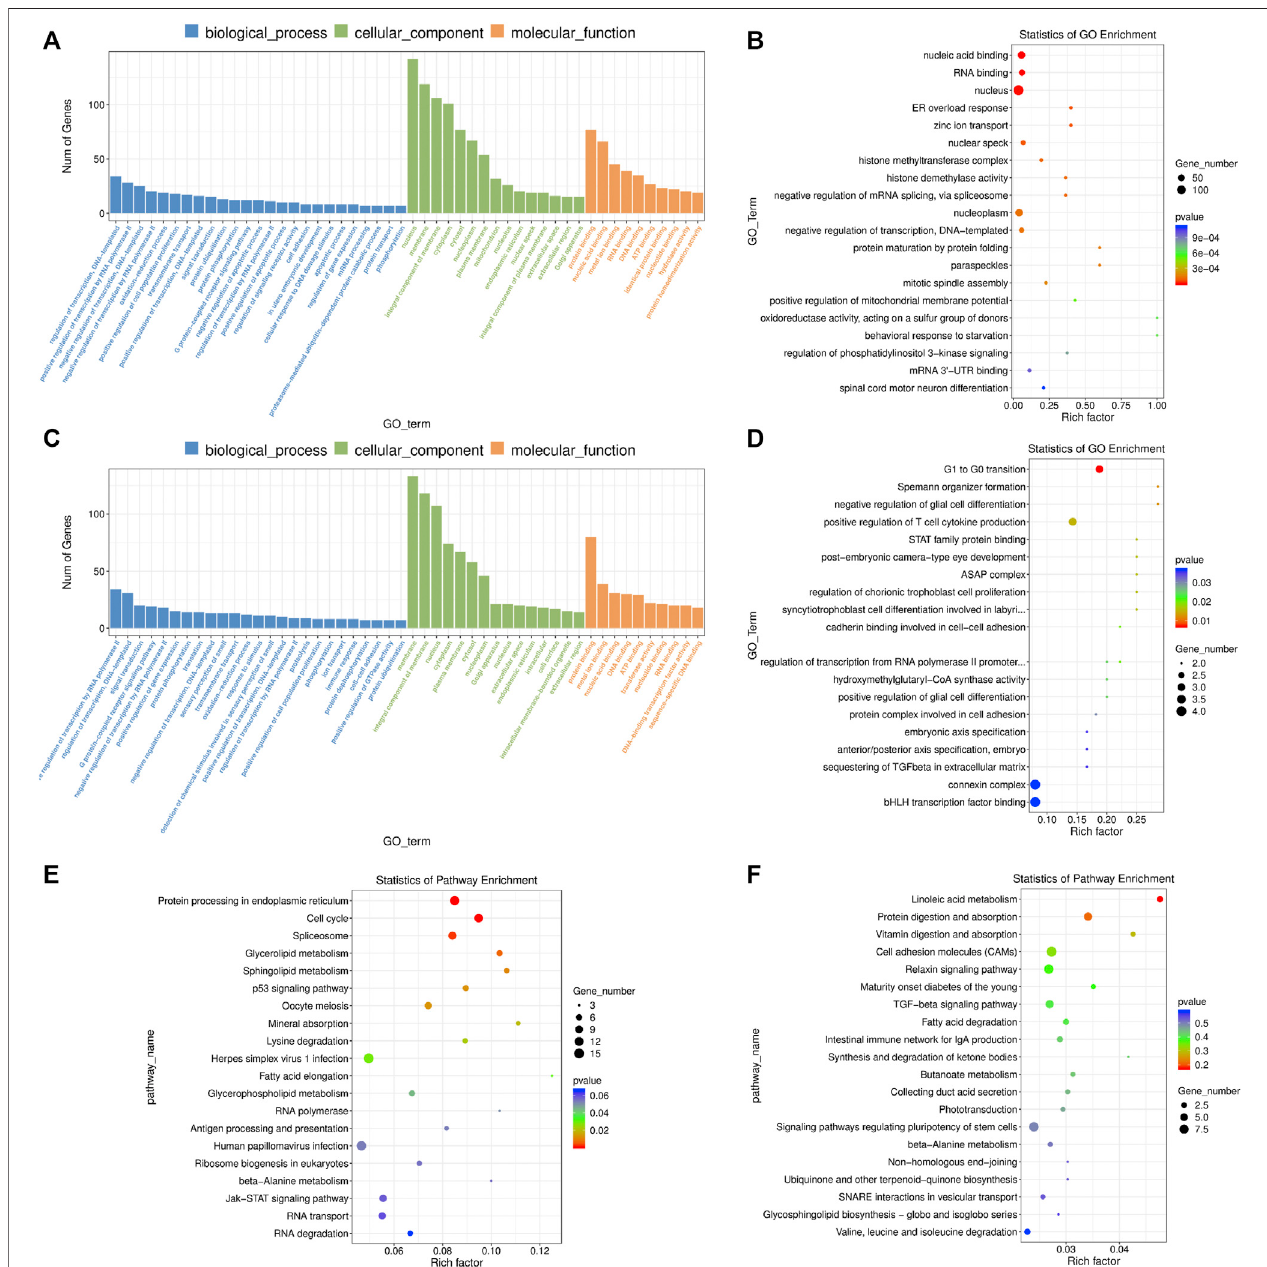
FIGURE 6 | GO and KEGG enrichment analysis ofdifferentially expressed (DE) mRNAs and lncRNA targets in 4-cells derived from vitri fi ed porcine cloned zygotes. (A) Histogramand (B) scatterplotofGOenrichmentforDEmRNAs; (C) histogramand (D) scatterplotofGOenrichmentfortargetgenesofDElncRNAs; (E) scatterplot of KEGG enrichment for DE mRNAs; (F) scatter plot of KEGG enrichment for target genes of DE lncRNAs.